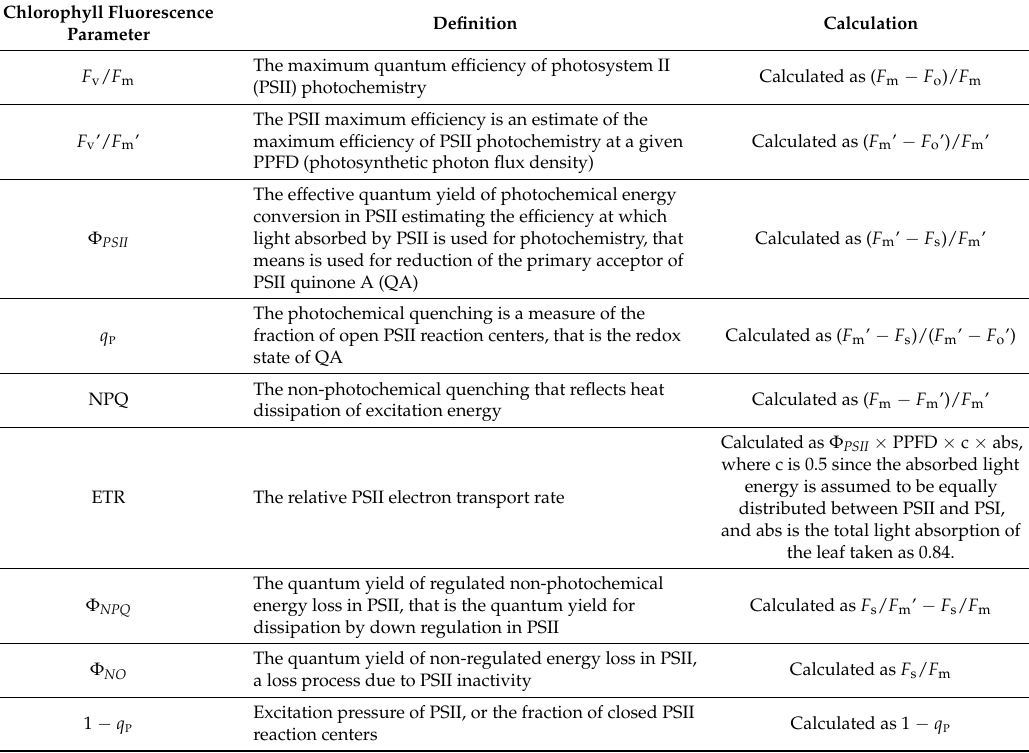
Table 1. Definitions of the calculated chlorophyll fluorescence parameters with their calculation